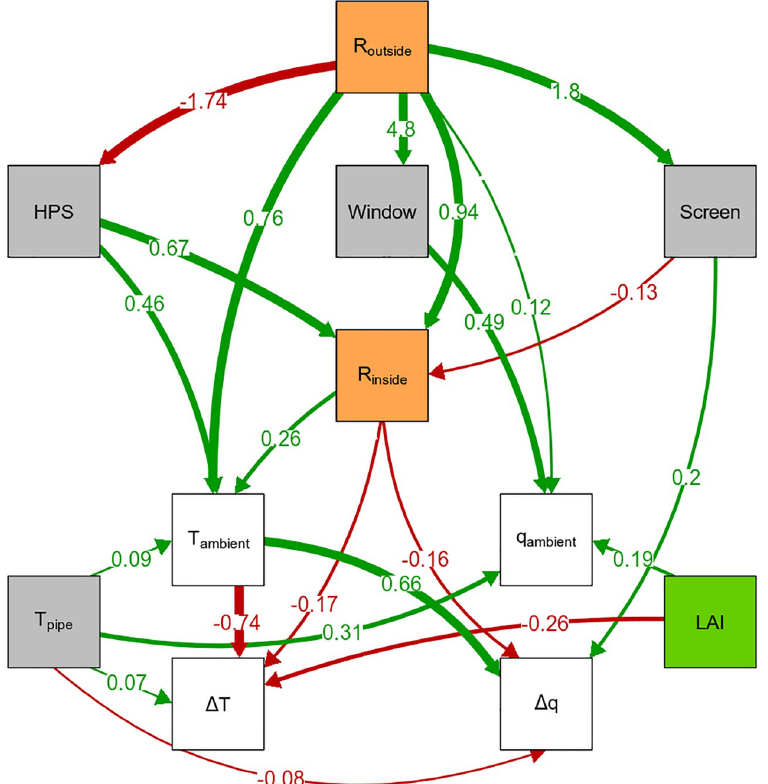
Fig 6. Causal path model for the difference between canopy air and ambient temperature ( Δ T ) and absolute humidity ( Δ q ). Causal path model that was consistent with the data (p = 0.058, df = 32, Fisher’s C = 45.47), where arrows show a causal relation and the values the standardised path coefficients. The standardised path coefficients measure the effect of one variable on another in standard deviation units. The colour of the boxes denote the following: white represents the climate variables, grey represents the climate control measures, green represents the crop and orange represents radiation. Paths with a standardised path coefficient below 0.07 have been removed for presentation purposes. For the complete diagram see S5 Fig. Abbreviations: R outside is outside global radiation; R inside is inside global radiation; HPS is High Pressure Sodium lamps, supplemental assimilation lighting; Window is window opening (open or closed); Screen is shading screen position (open or closed); T pipe is temperature of the heating pipe; LAI is leaf area index; T ambient is ambient temperature, temperature above canopy; q ambient is ambient absolute humidity, absolute humidity above canopy ; Δ T is difference between ambient temperature and air temperature in the canopy ; Δ q is difference between ambient absolute humidity and absolute humidity in the canopy. Also see Table